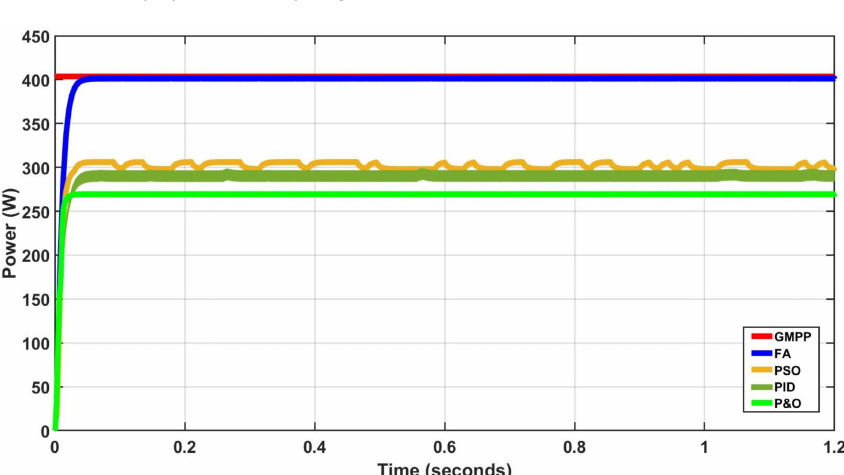
Figure 35. Duty cycle of Firefly Algorithm for Case-3.